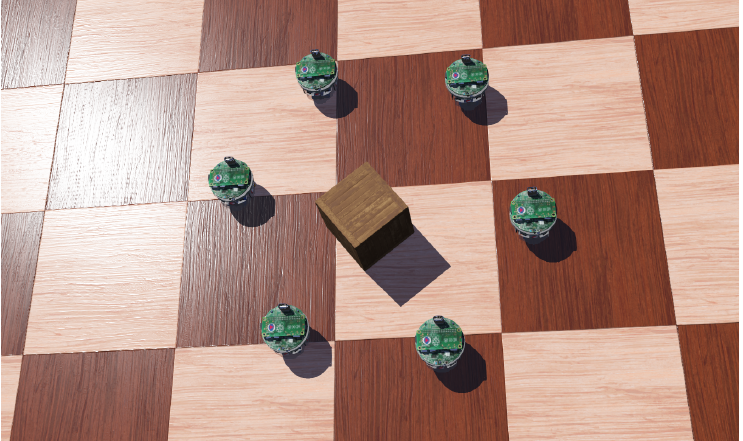
Figure 9. An illustration of pattern (circle) formation with five e-puck robots which are guarding a box in the